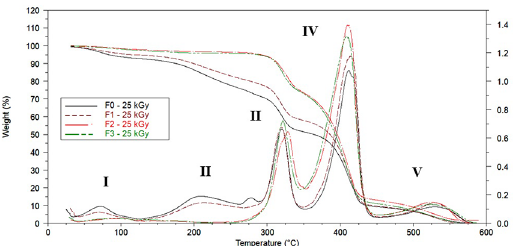
Figure 4. TGA/DTG curves of 25 kGy irradiated blends